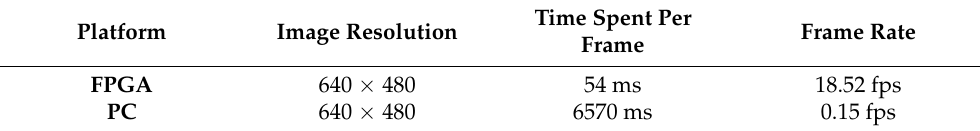
Table 4. Speed table of the laser virtual scale algorithm running on an FPGA and a PC.